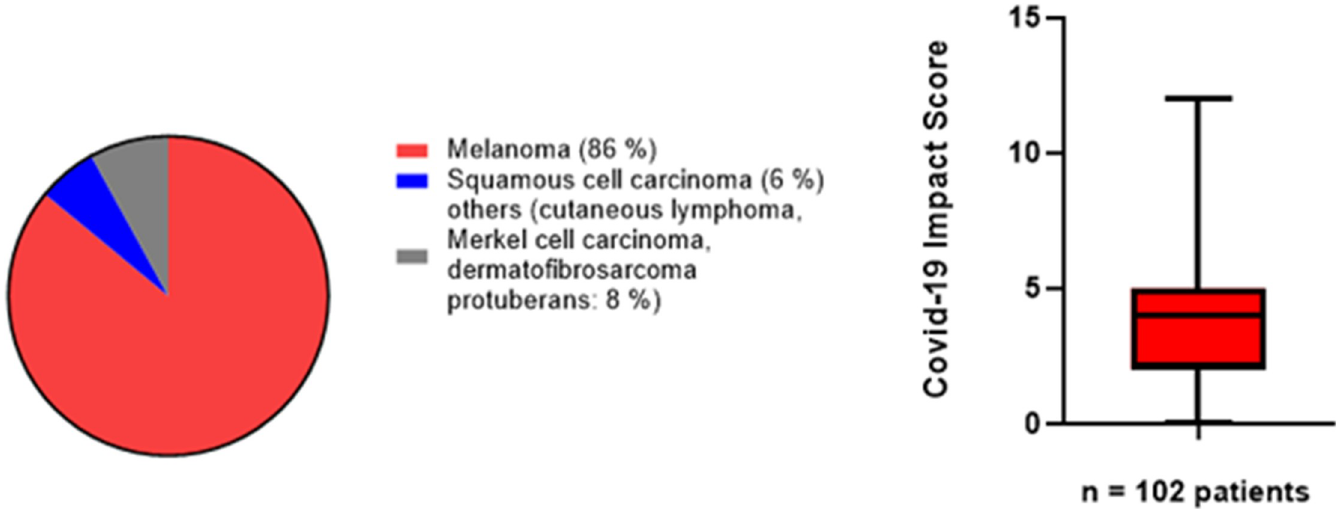
Fig 2. Distribution of the different types of skin cancer (A) and Covid-19 Impact Score (B).